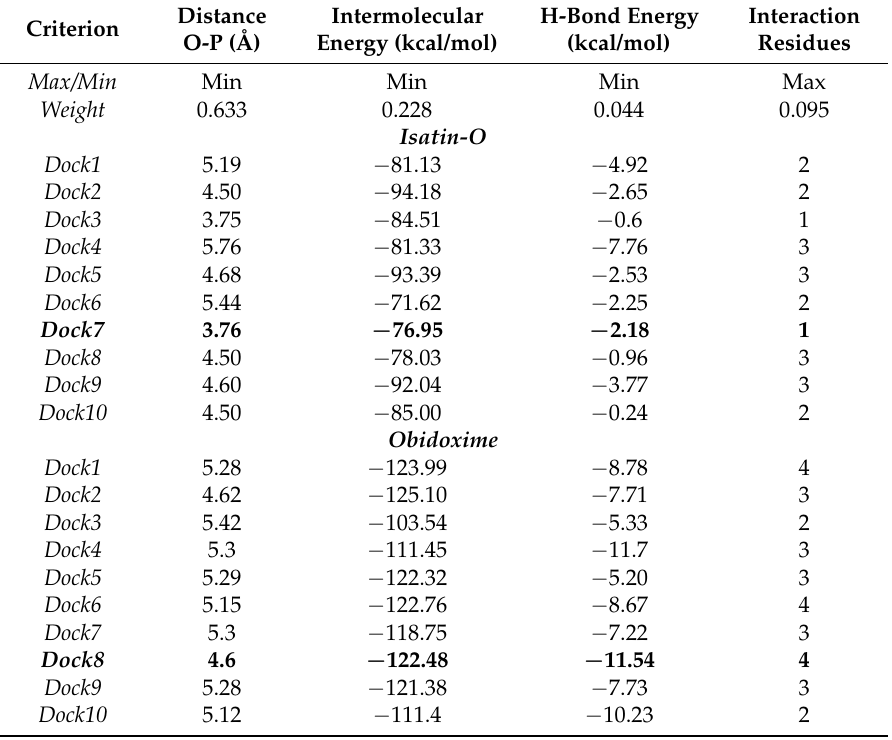
Table 2. Decision matrix (isatin-O and obidoxime). The poses with better performances are shown in